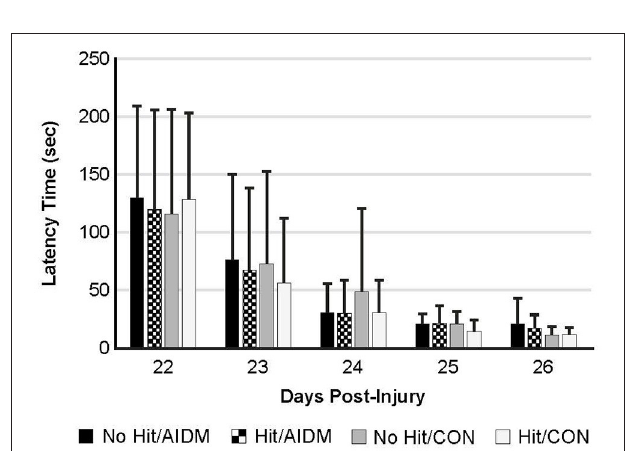
FIGURE 6 | The Barnes Maze was used to determine spatial learning and memory retention in TBI-exposed (Hit) and non-TBI (No Hit) rats. Pre-injury, cumulative average latency (sec) to locate the hidden box was measured over 5 days (days − 8 to − 4, with date of injury assigned day 0). The anti-inflammatory (AIDM) or control (CON) diets were started on Day 0. On days 22–26 post-TBI, with the box moved to a new location ( ∼ 90 degrees away from the first location), latency was again measured over 5 consecutive days and values reported at each. No significant difference was found between animals at any time points. Bar heights represent mean value ± SDEV, for n = 12